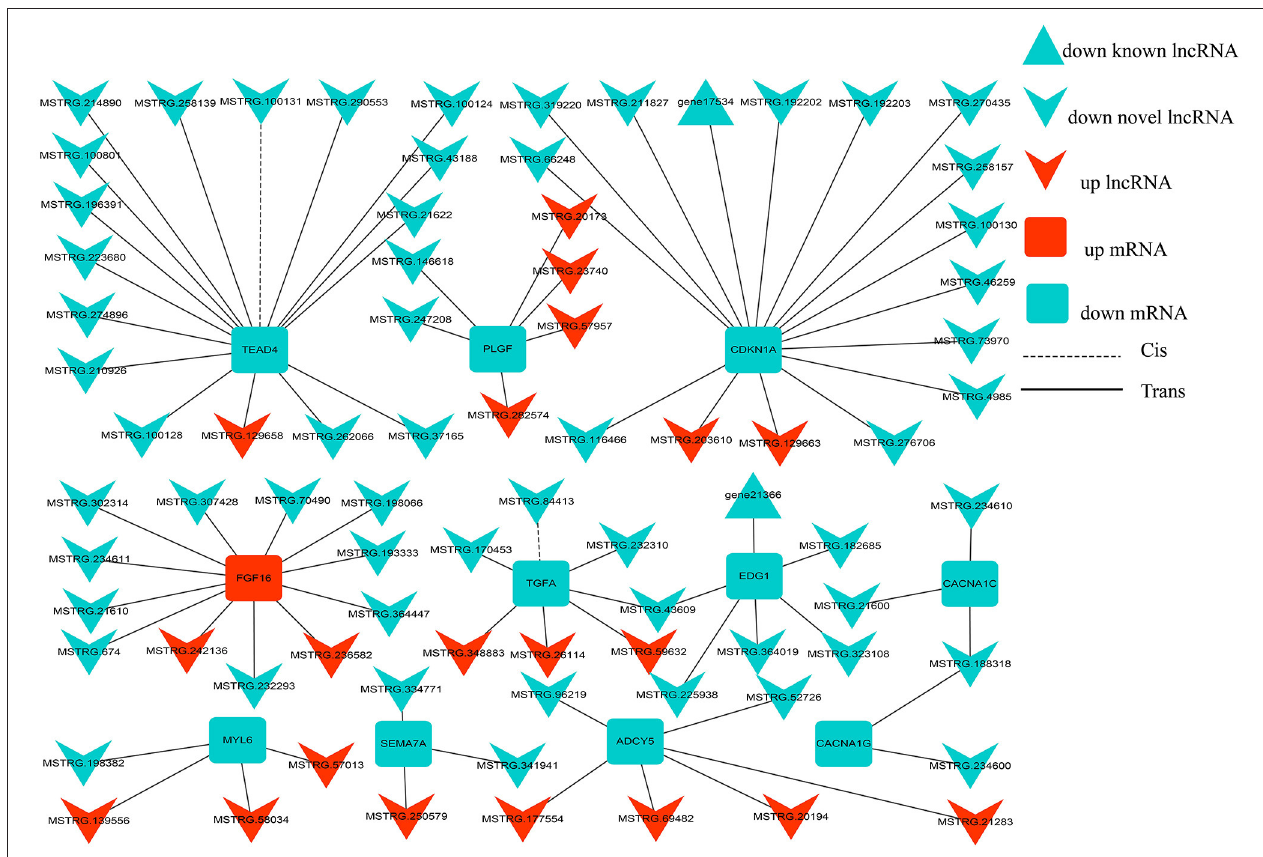
FIGURE 7 | lncRNA-mRNA interaction networks. The interaction networks of lncRNAs and their corresponding target genes in SP42 vs. LP42, where the solid and dashed lines represent trans- and cis-regulation functions, respectively; red and green represent up- and downregulation, respectively; and round rectangle, V and triangle represent mRNAs, novel lncRNAs and known lncRNA,